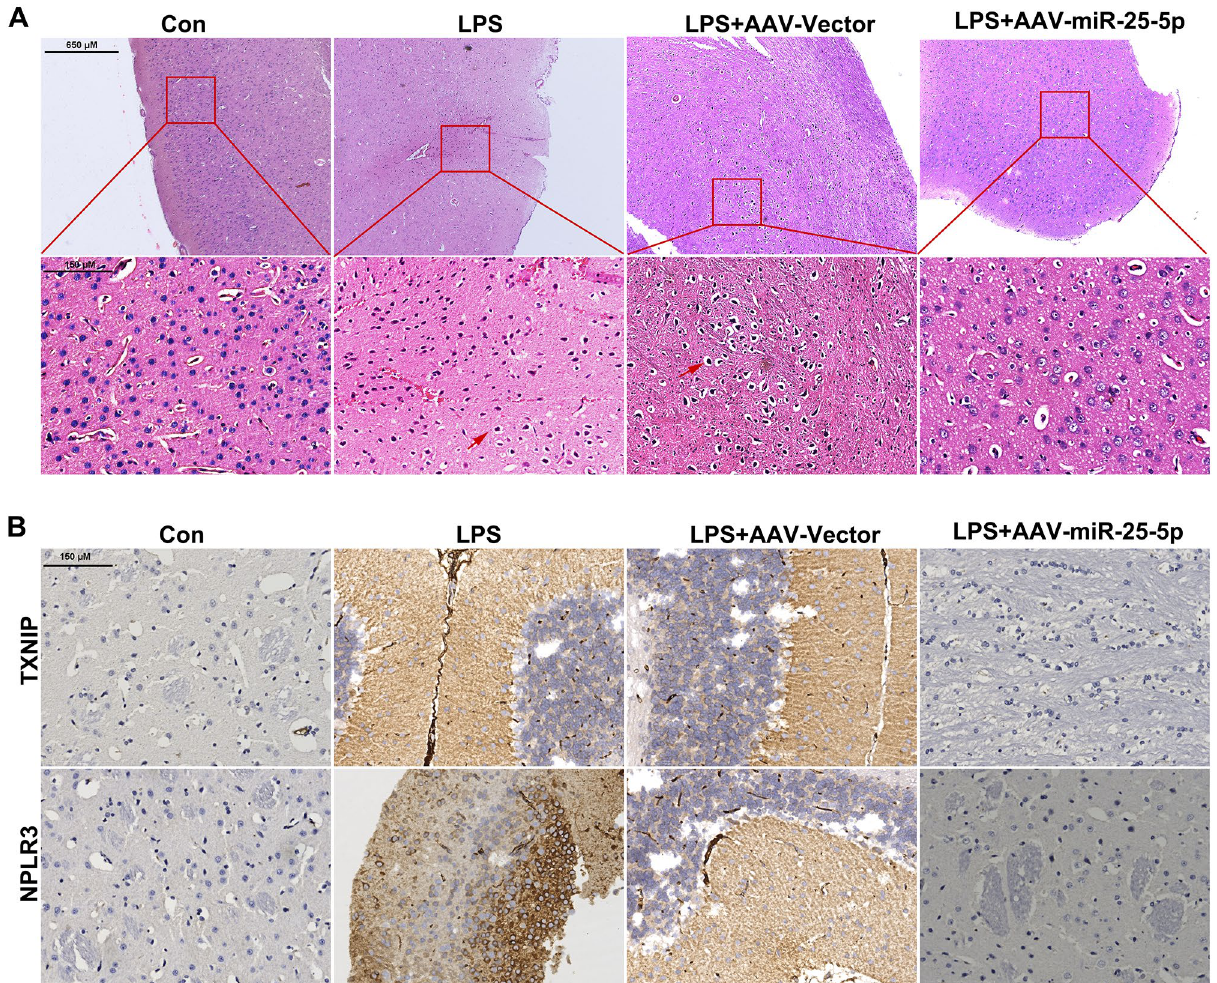
Figure 5. Neuroprotective effects of miR-25-5p on the brain of septic rats. (A and B) Effects of AAV-miR-25-5p on brain morphology of septic rats using HE ( A ), and TXNIP and NPLR3 signals on brain using IHC assay ( B ). Con: negative control, LPS: lipopolysaccharide, AAV: adeno-associated